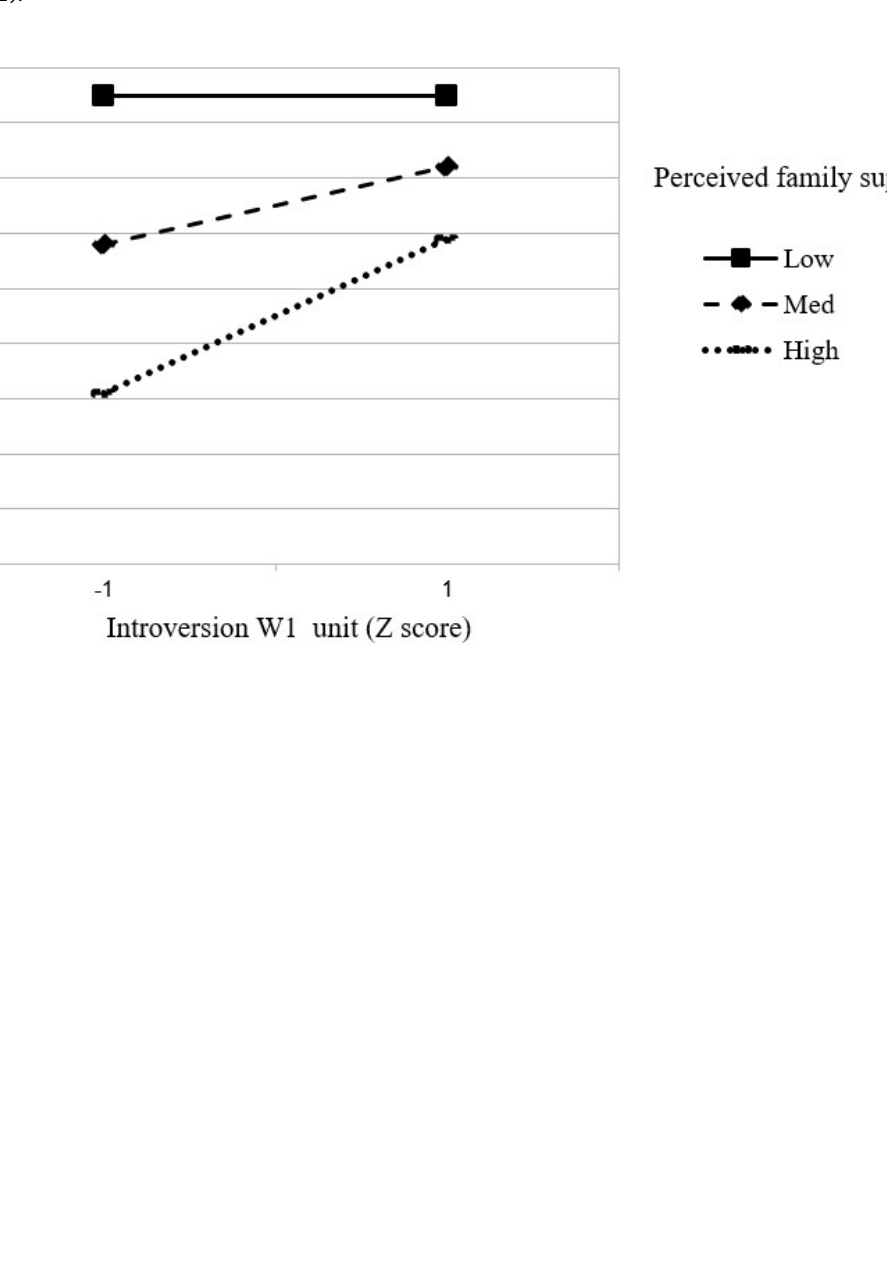
Figure 2. The moderating effect of perceived family support (W1) in the relationship between introversion (W1) and compensatory use of social networking sites (SNS;